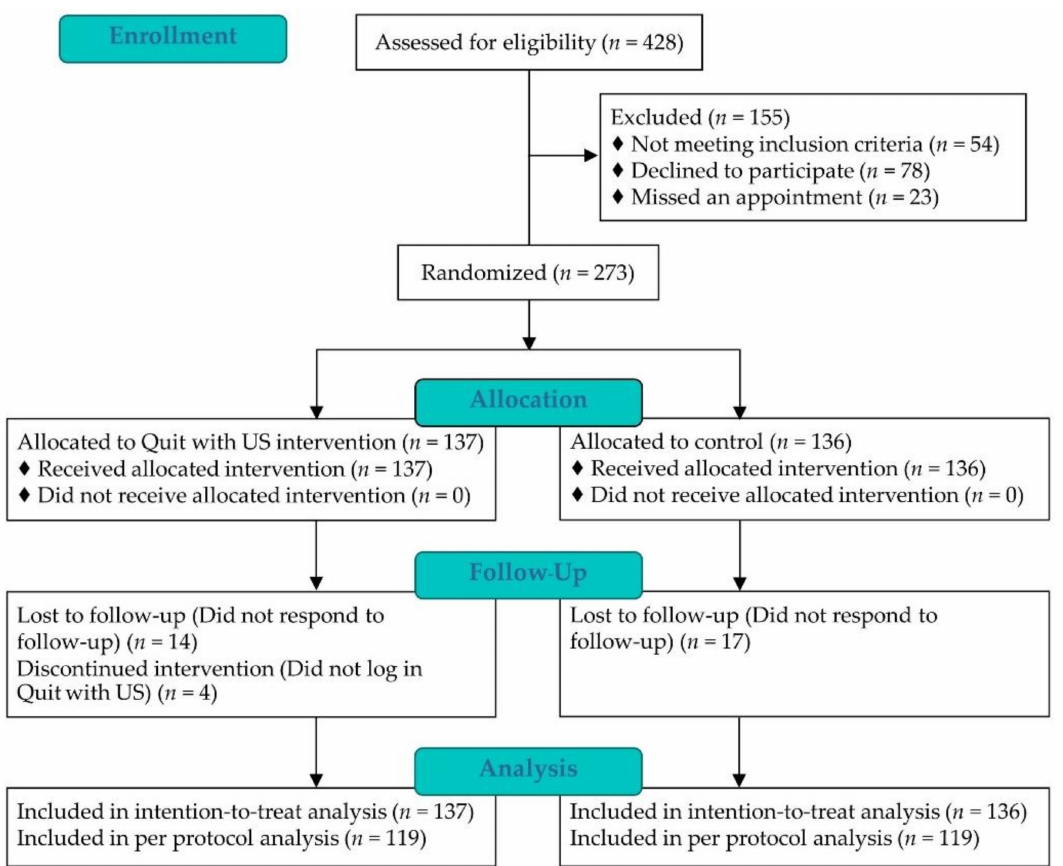
Figure 2. CONSORT flow diagram of Quit with US